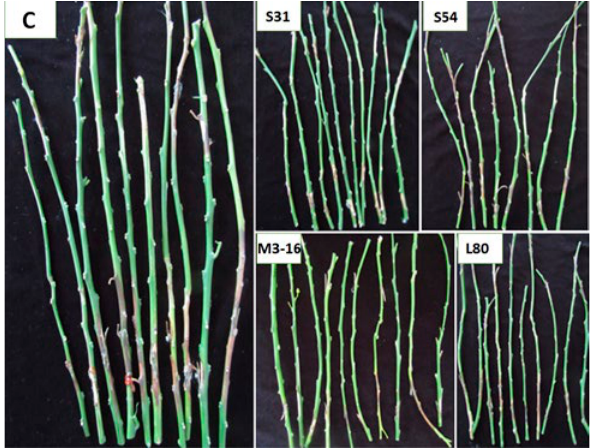
Figure 4. Suppression of branch canker on clementine mandarin for the trial conducted under partly controlled greenhouse condi- tions. Host branches were cut and leaves removed for improved view of the symptoms. C: Plants inoculated with Phytophthora citrophthora (Pc) without bacterial treatment. S31 and S24 indicate plants treated with endophytic bacteria, and M3-16 and L80 indi- cate those treated with halophilic bacteria.